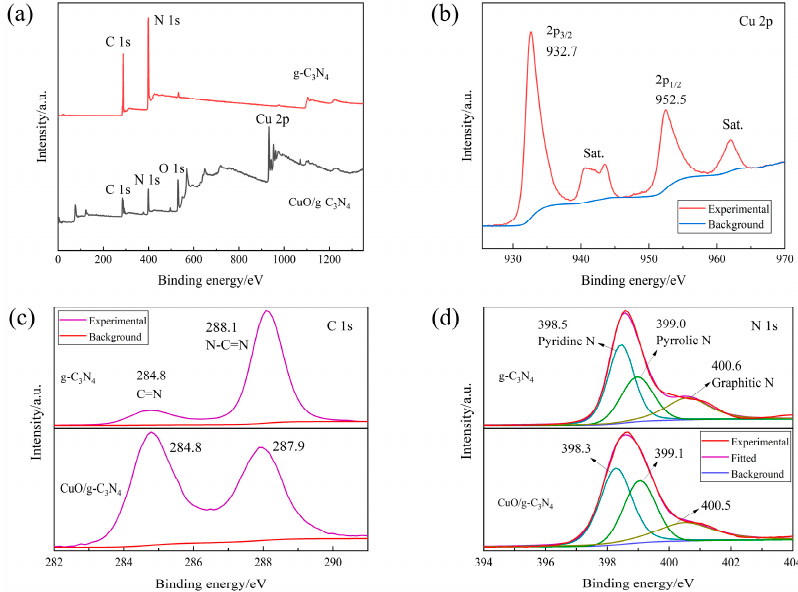
Figure 5. XPS spectra of g-C 3 N 4 and CuO/g-C 3 N 4 : ( a ) full scan, ( b ) Cu 2p, ( c ) C 1s, ( d ) N